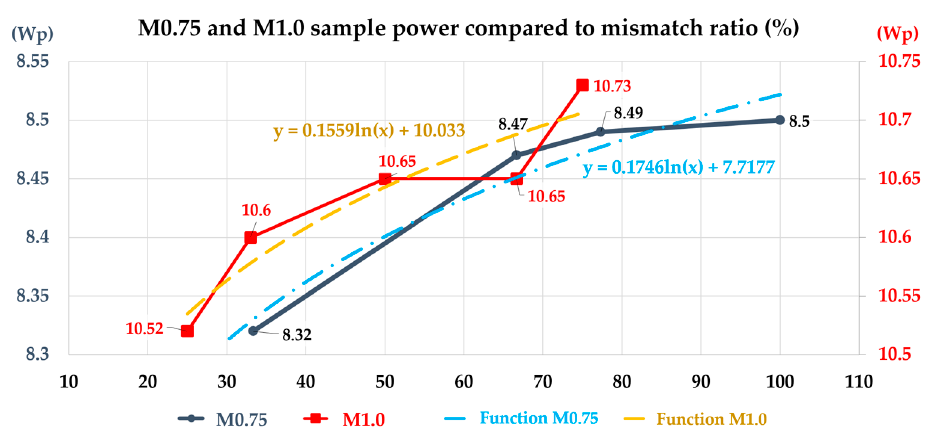
Figure 12. Power output of the M0.75 and M1.0 compared to the electrical mismatch ratio.